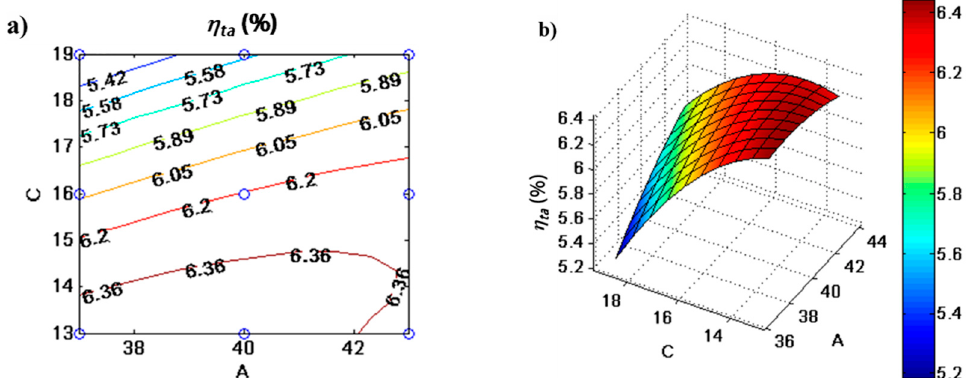
Figure 8. Contour plot ( a ) and 3D-response surface ( b ) of thermoacoustic e ffi ciency η ta at “Junction”, against the combined e ff ect of operating frequency and inertance inner diameter A and C, respectively.